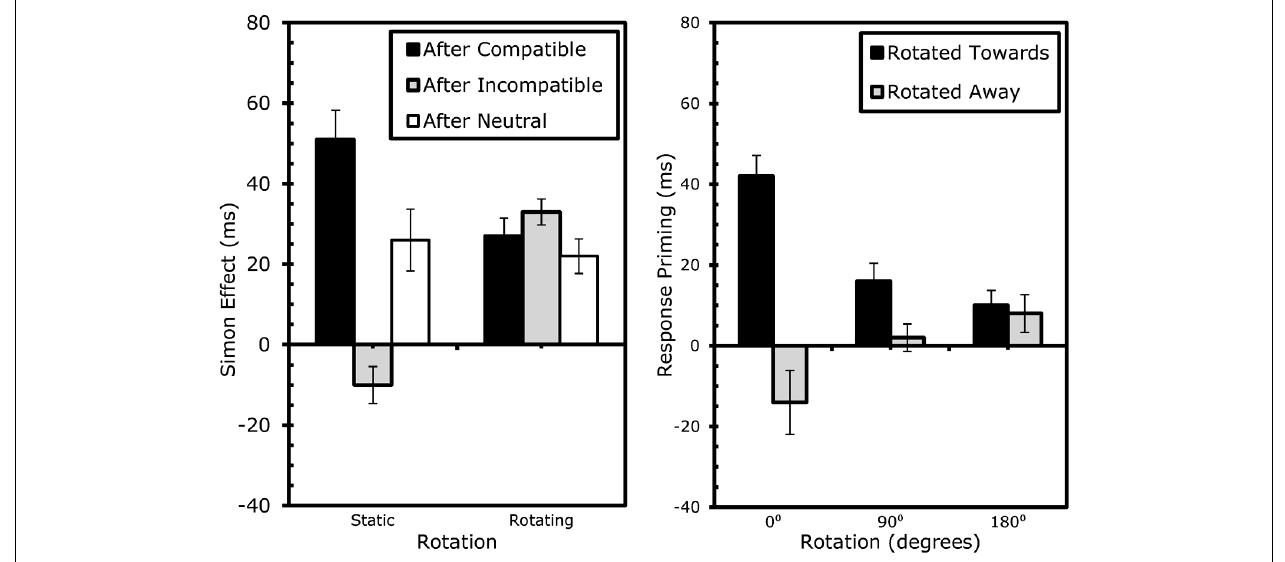
FIGURE 4 | Results Experiment 2: effects of rotation on sequential Simon effects (left) and event-coding (right). Error bars represent standard error of the Simon (left) or response-priming (right) effect within the specific condition.